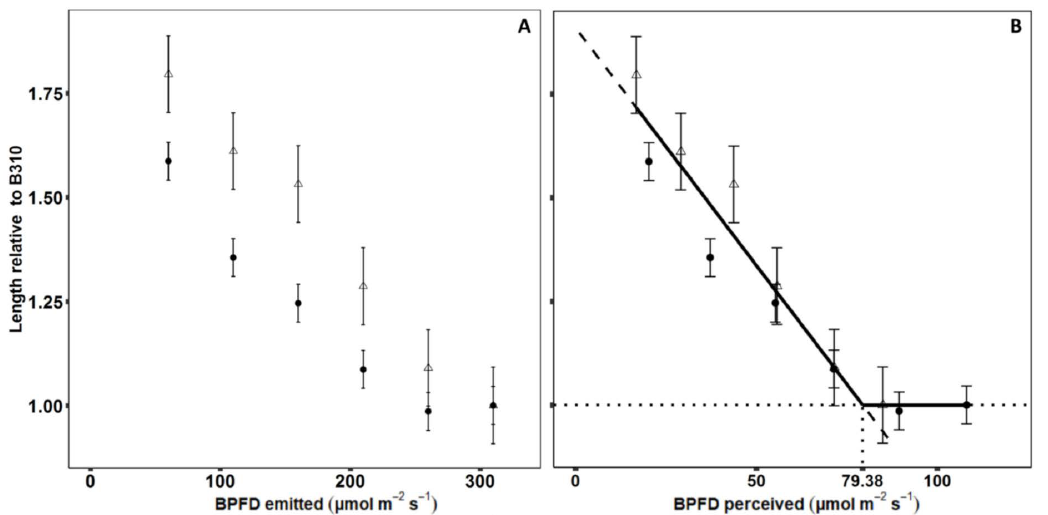
Figure 3. Least square mean of length of second (point) and third (triangle) internode relative to B310 in response to BPFD emitted by the LED modules ( A ) or simulated BPFD perceived by the internode ( B ). Dashed line showing the function fitted to relative internode lengths higher than one and dotted lines showing the interception of the function with 1. Black line showing the final response function to BPFD. Error bars indicate standard error of the LS-mean ( n =